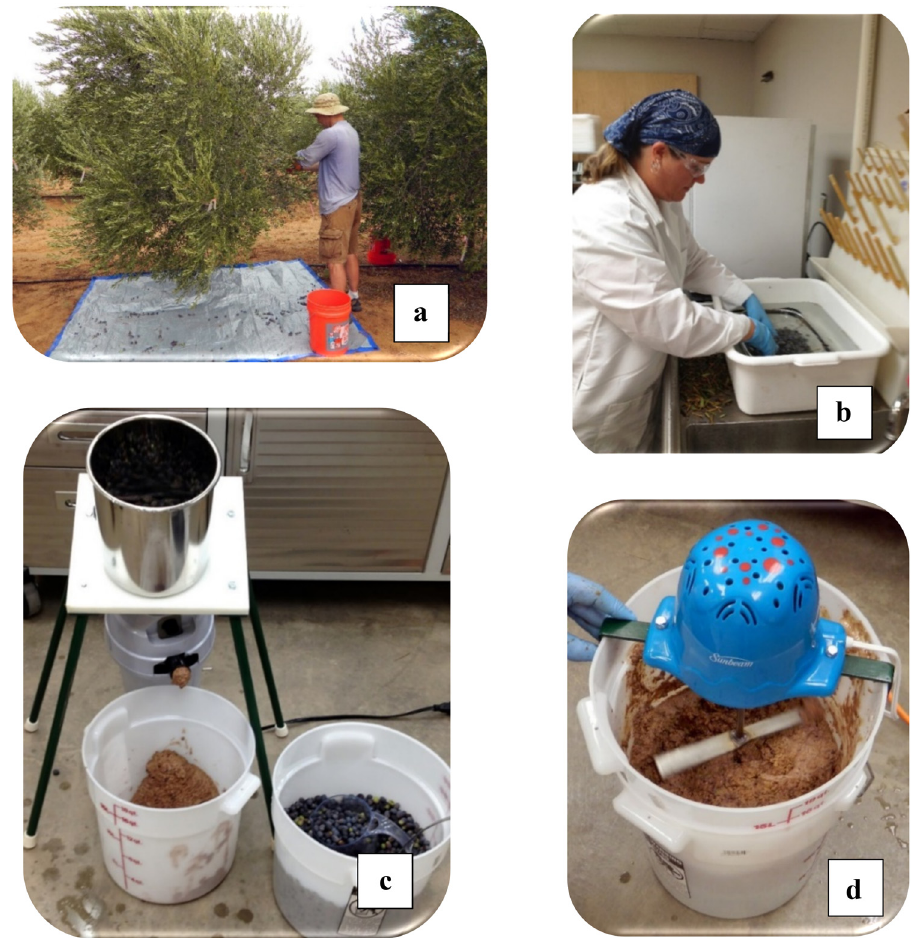
Figure 1: Olive oil preparation: hand harvesting fruit ( a ) , washing fruit ( b ) , crushing fruit ( c ) , and malaxation of fruit paste ( d ) .